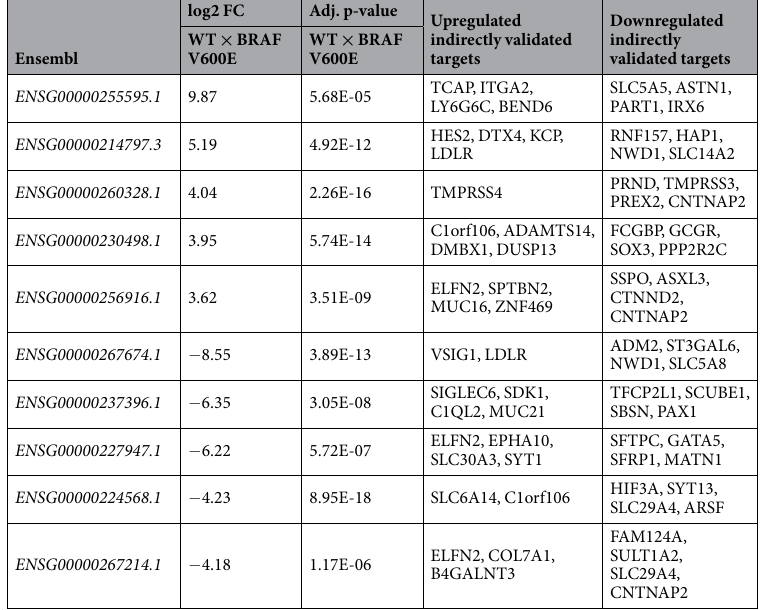
Table 3. Top 5 upregulated and 5 downregulated DE lncRNAs between WT × BRAF V600E with examples of indirectly validated